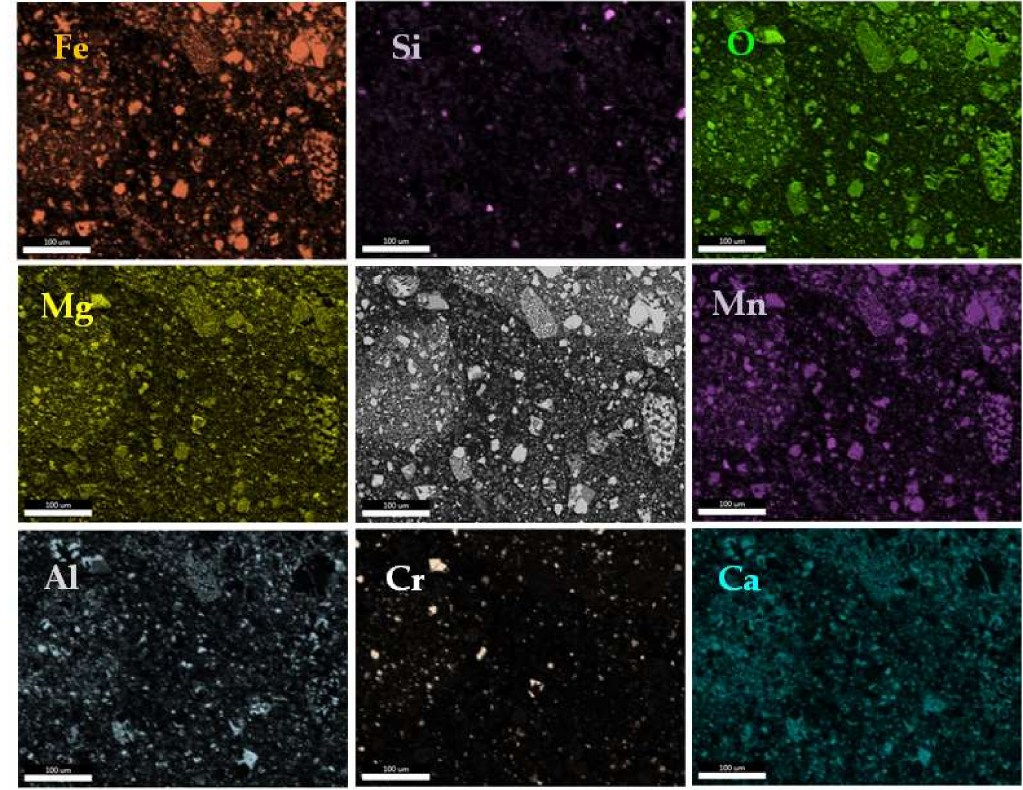
Figure 8. Distribution of some chemical elements in the non-magnetic fraction of the size fraction +0.25–1 mm determined by EDS 2D mapping in SEM analysis.